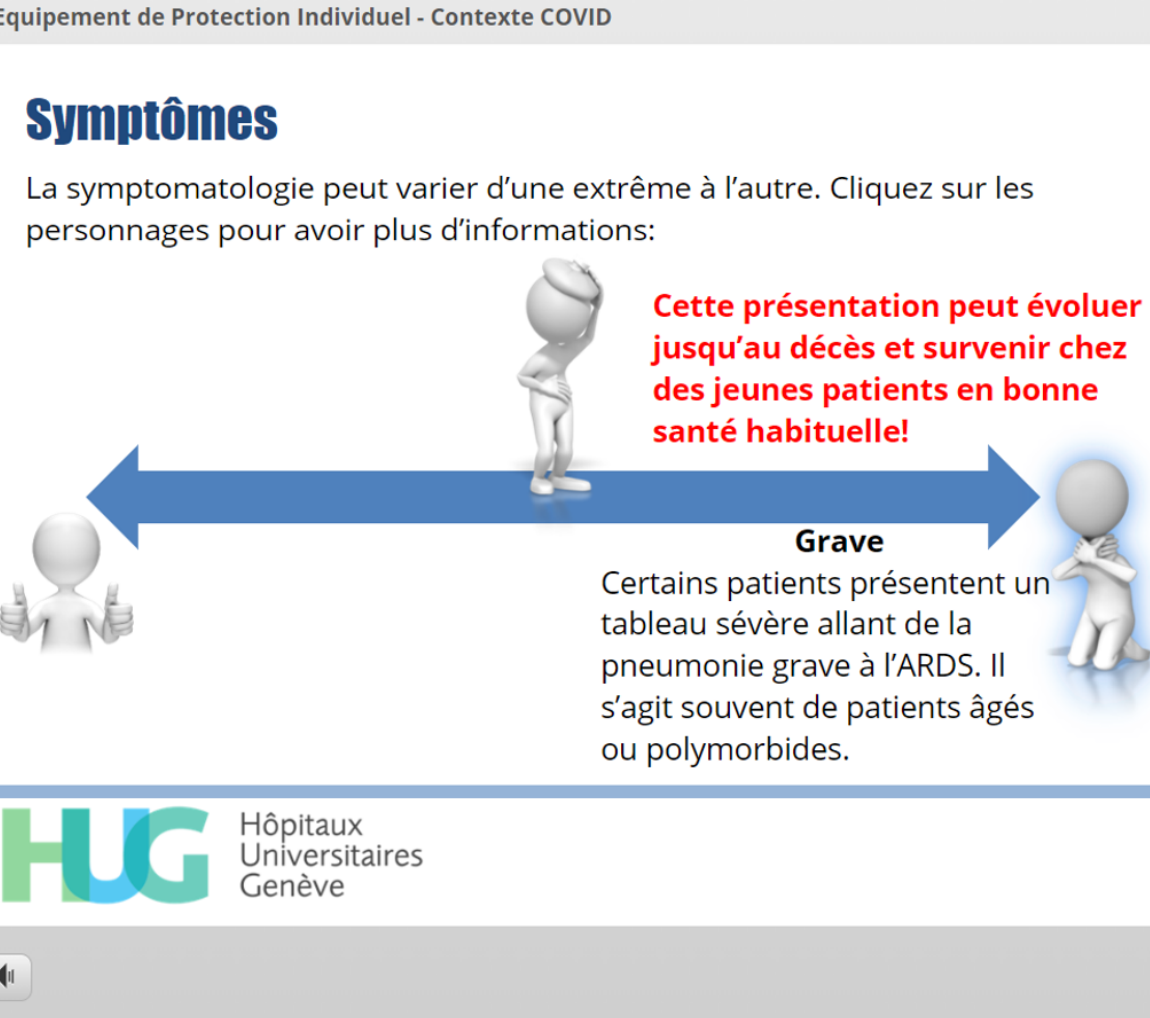
Figure 5. Use of triggers to avoid content skipping. The “very ill” patient on the rightmost side of the slide has been clicked and is therefore highlighted. The learning content related to this presentation is displayed; however, the Continuer (Continue) button does not appear because the learner must click at least one of the other